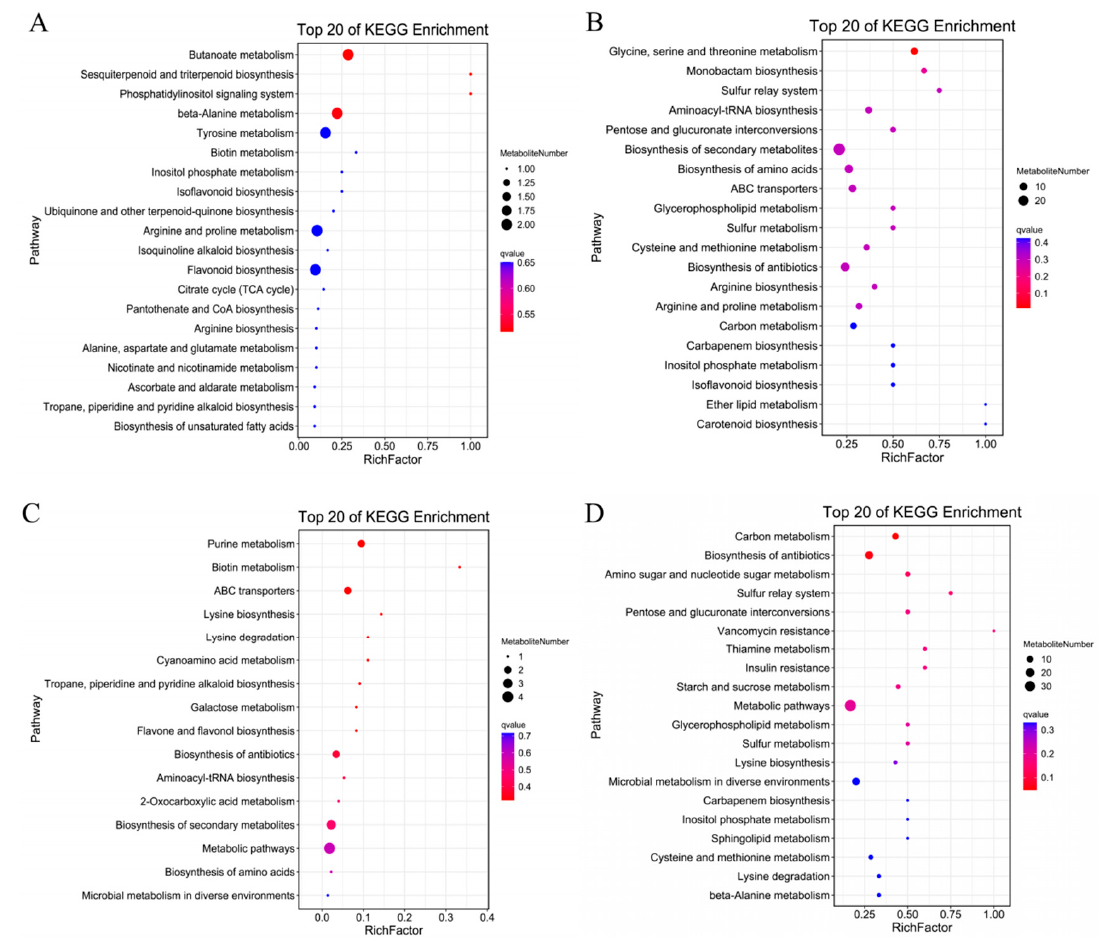
Figure 9. Differential metabolite enrichment bubble diagram of cotton seedling roots under ( A ) CK vs. MT, ( B ) CK vs. S, ( C ) S vs. MS and ( D ) MT vs. MS treatments. Note: KEGG, Kyoto Encyclopedia of Genes and Genomes; CK, control treatment; MT, melatonin treatment; S, NaCl treatment; MS, combined melatonin and NaCl treatment.